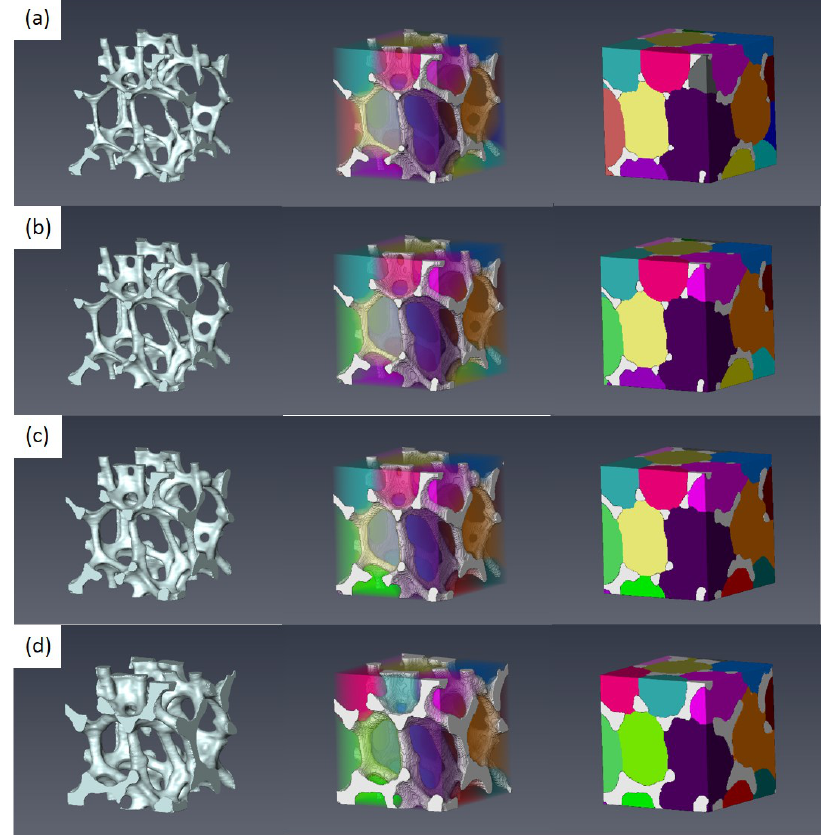
Figure 4. Four different model domains with different strut thickness: ( a ) thinner, ( b ) standard, Figure 4: Four different model domains with different strut thickness: (a) thinner, (b) stan- dard, (c) thicker, and (d) the thickest models ( c ) thicker, and ( d ) the thickest